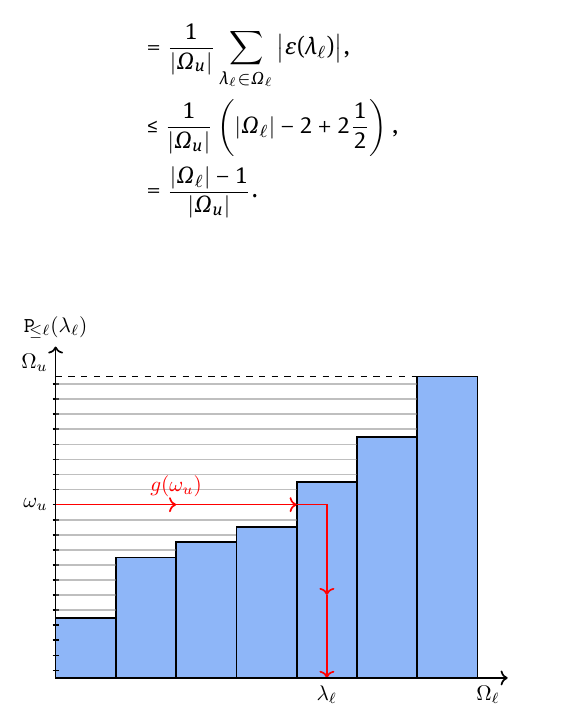
Figure 16: Theorem 2: Approximately sampling a non-uniform distribution using inverse sampling